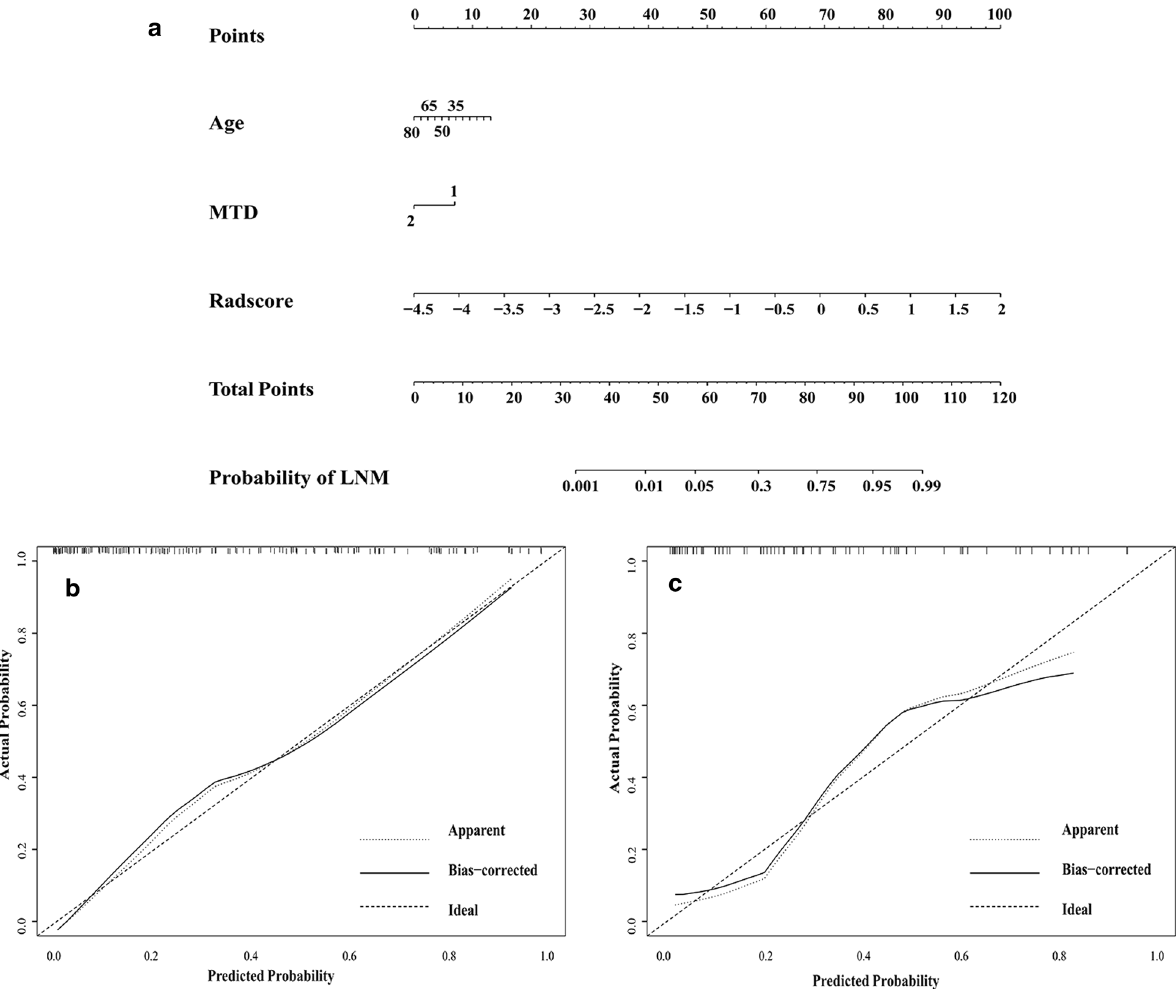
Fig. 4 Nomogram was developed by integrating the clinical factors (age and MTD) and combined radiomics signature in the training set ( a ); Calibration curve of the radiomics nomogram for predicting LNM in the ( b ) training set ( p